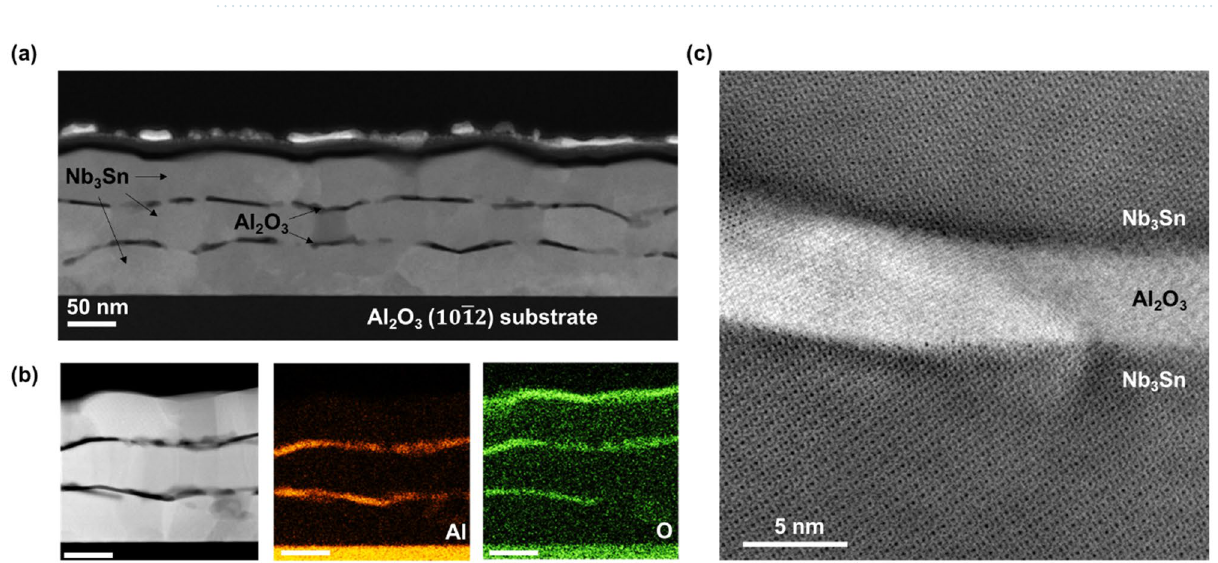
Figure 4. Cross-sectional transmission electron microscopy images of Nb 3 Sn/Al 2 O 3 multilayer heterostructures ( a ) Low-magnification image of trilayer morphology. ( b ) EDS compositional mapping of Al and O showing no interdiffusion between Al 2 O 3 and Nb 3 Sn. ( c ) High-magnification image of the interfaces between Al 2 O 3 and Nb 3